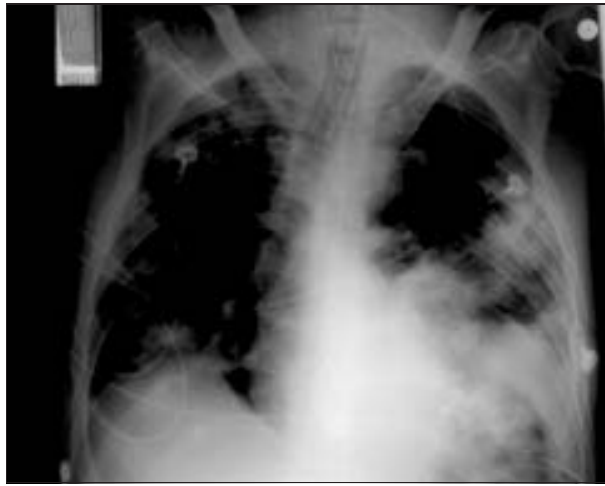
Figure 3) Chest radiograph of the patient postoperatively demon- strating extensive bilateral pulmonary